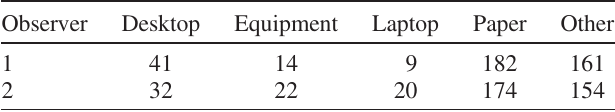
TABLE III. Sample contingency table used to determine if two distributions are statistically different. Two observers docu- mented the same lab period, and a chi-squared test was performed to determine if the resulting distributions are statistically similar or dissimilar. Here, we obtain p > 0 . 1 , indicating that the observers captured the same distribution of student